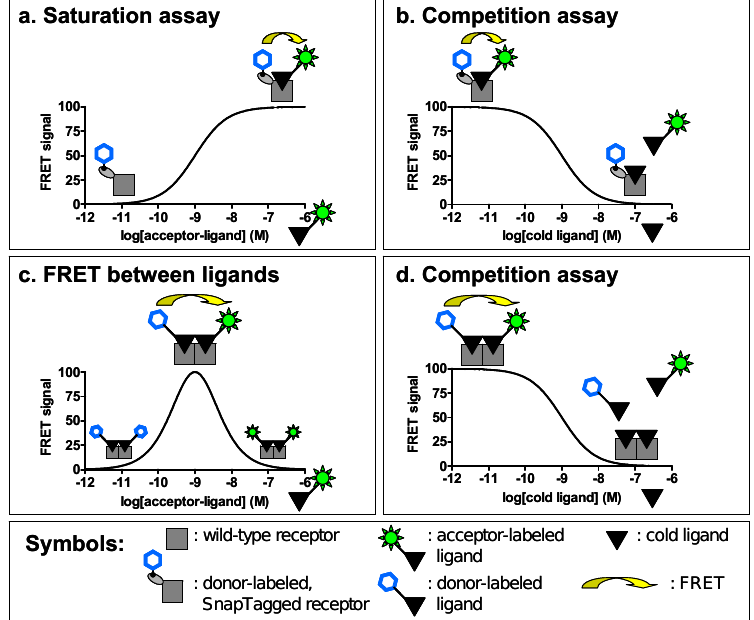
Figure 4. Principle of FRET-based binding assays. (a) Saturation assays can be performed simply in homogeneous conditions with a donor-labeled receptor (e.g. by fusing the receptor to a SnapTag suicide enzyme). FRET signal corresponds to the specifically bound fluorescent ligand; (b) The bound fluorescent ligand can be displaced by increasing concentrations of unlabeled “cold” ligand; (c) FRET can also be measured in optimum conditions when a donor-labeled ligand and an acceptor-labeled one bind simultaneously to a GPCR oligomer; (d) This specific FRET can be displaced by increasing the concentrations of unlabeled ligand, providing the basis for a possible high-throughput screening